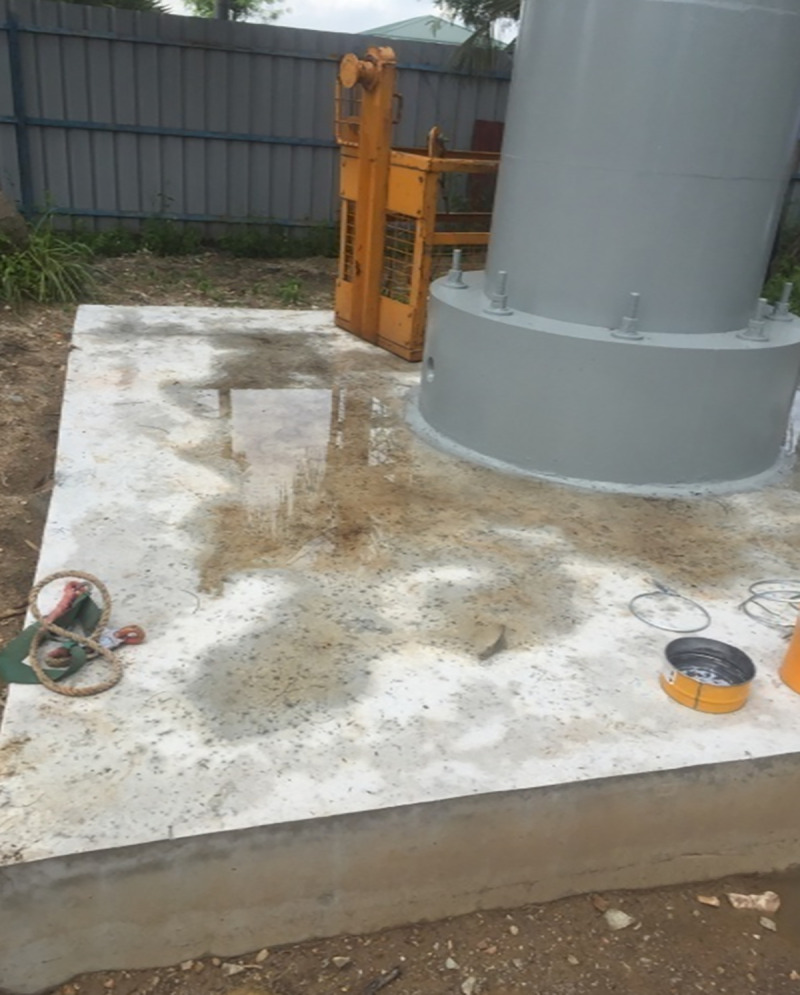
Tower foundation.